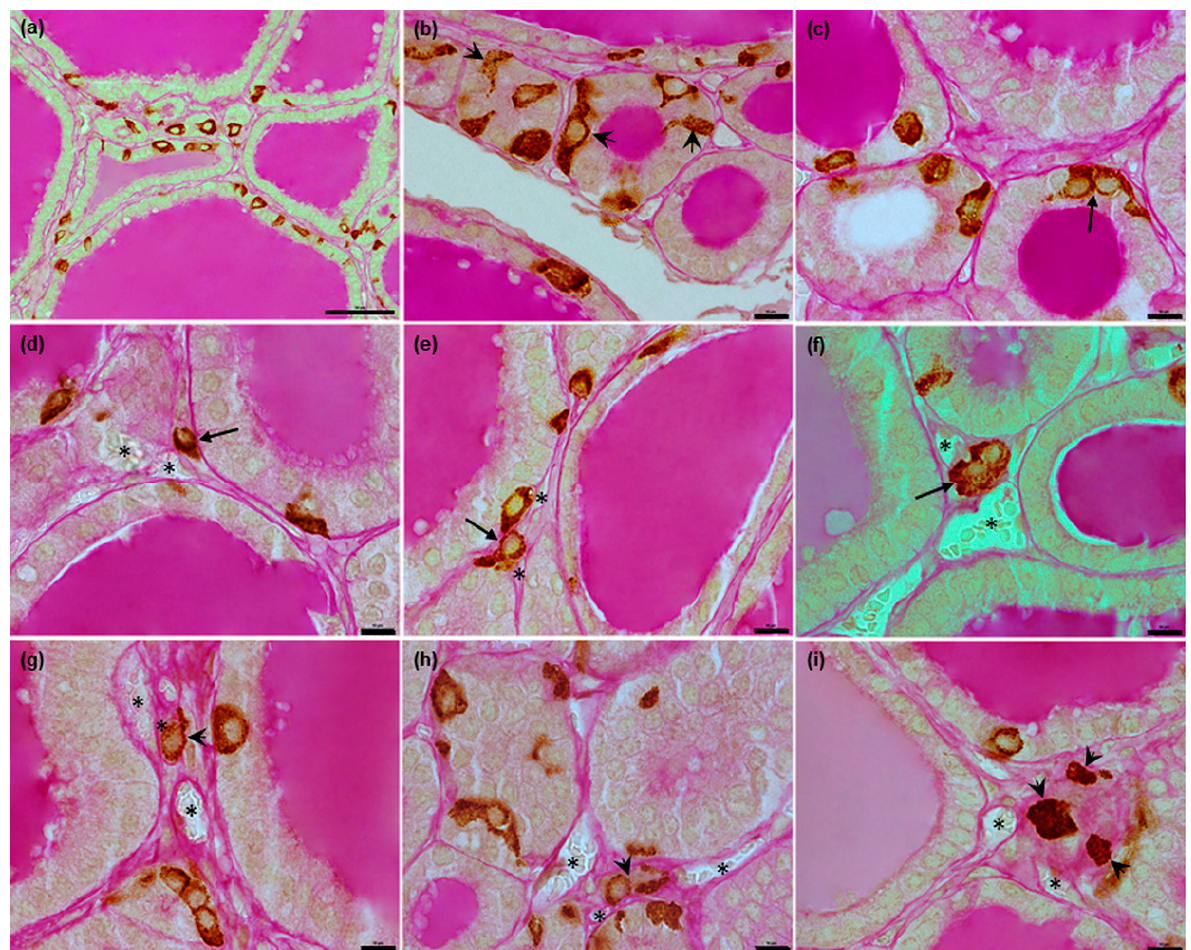
Figure 8. Representative images of bovine C thyrocytes position in relation to the follicular wall. ( a – c ): C thyrocytes located in intrafollicular position: in the form of single cells scattered irregularly between T thyrocytes ( a , b ) or in small groups ( c , arrow), some cells possess cytoplasmic processes (arrowheads). ( d – i ): C thyrocytes located outside follicular wall: epifollicularly (arrows), separately